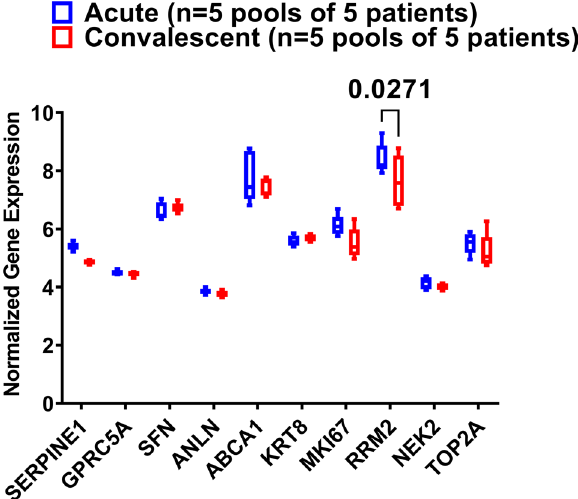
Figure 11. Normalized gene expression of genes Identified in whole blood of eosinophilic asthma (> 500 cells) compared to non-eosinophilic (eosinophils count less than 500) extracted from the expression profile of publicly available datasets